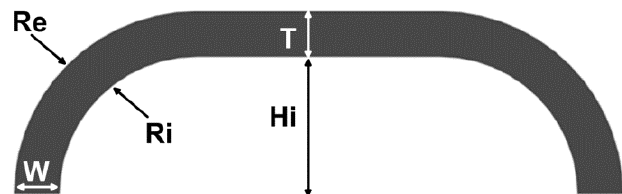
Figure 2. Cross section of the PSP1.1 (adapted from [37]).